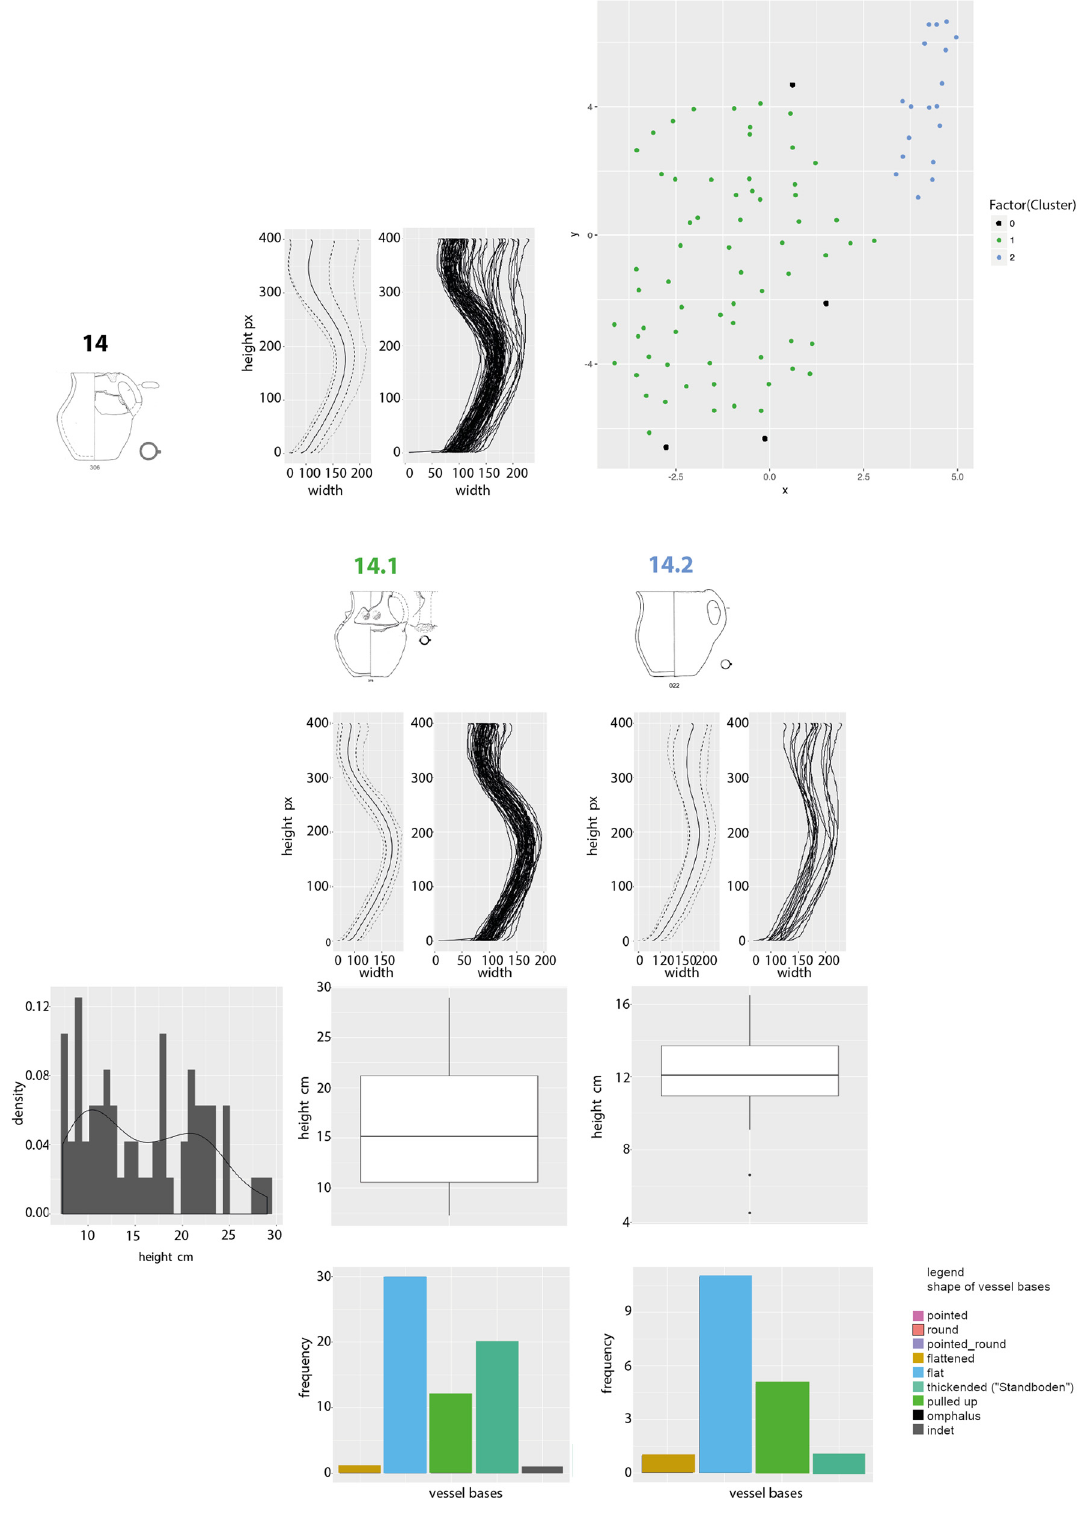
Figure 8: Cluster 14 and subclusters 14.1 and 14.2 ( fi gure: M. Hinz and C. Heitz, for the picture credits of the pottery drawings, see doi: 10.5281/zenodo.7258694 )